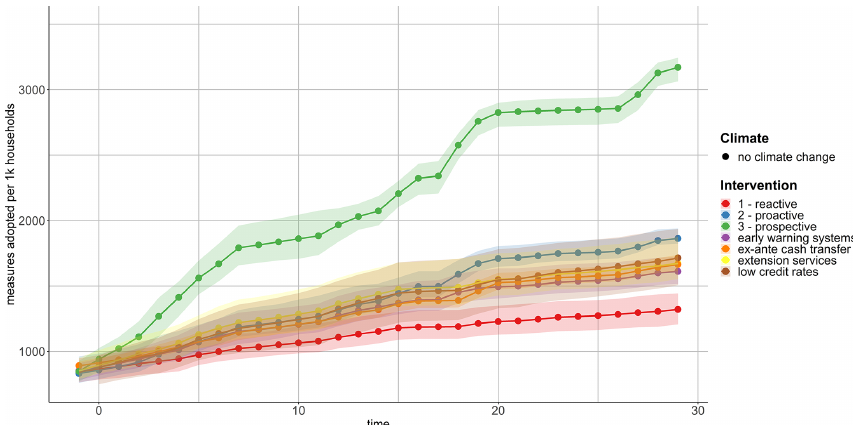
Figure 5. Total number of measures adopted per 1000 initialized households under no climate change, averaged over all runs. The shaded area indicates the variation – uncertainty introduced by different model initializations and by the different relative importance of the PMT factors for the decisions of households (sensitivity analysis). Year 0 marks the initiation of policy drought risk reduction interventions (indicated with different line